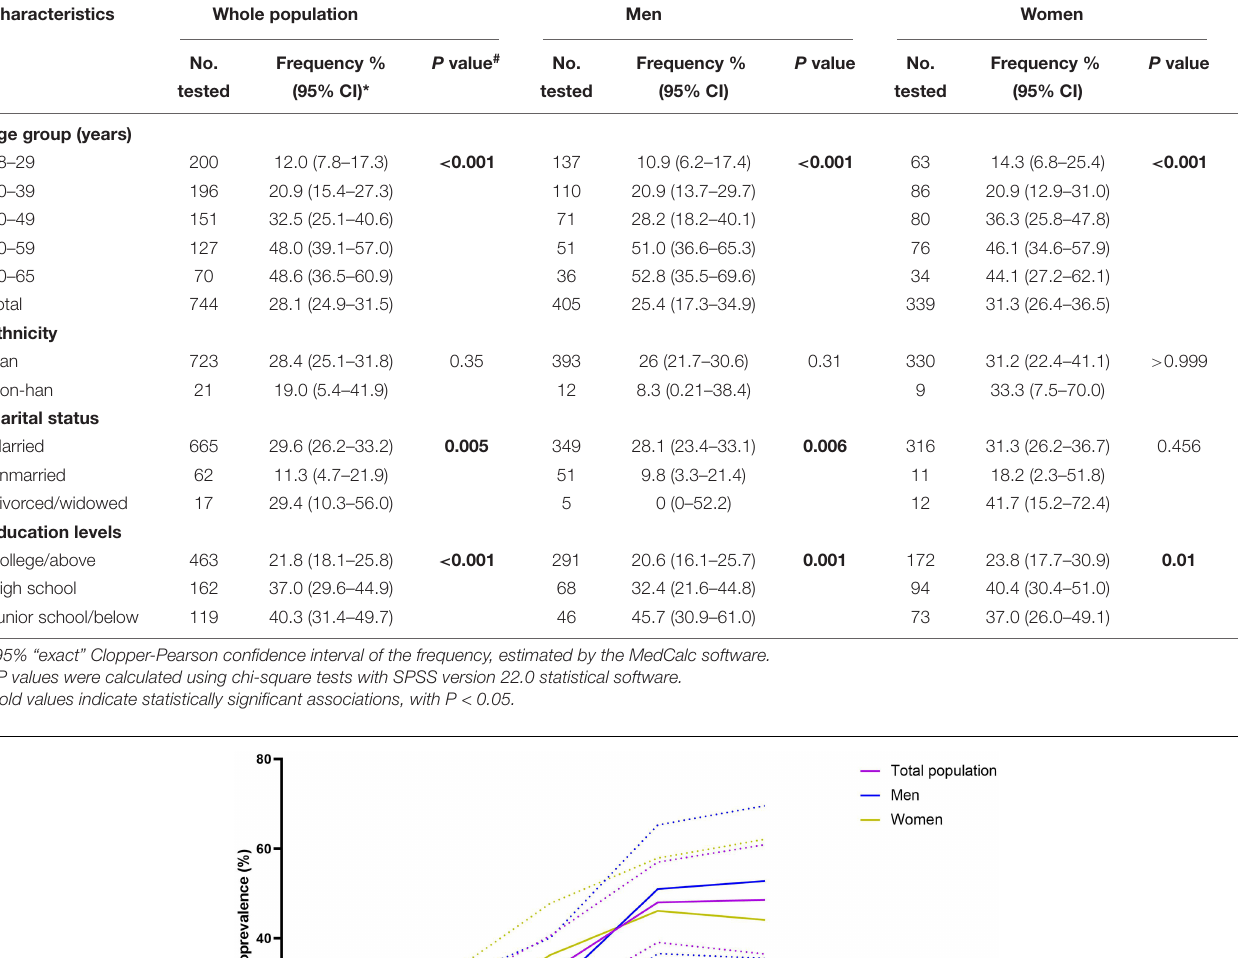
TABLE 2 | Frequency of antibody against C. trachomatis Pgp3 protein in a community population of Northern China in 2014. Characteristics Whole population